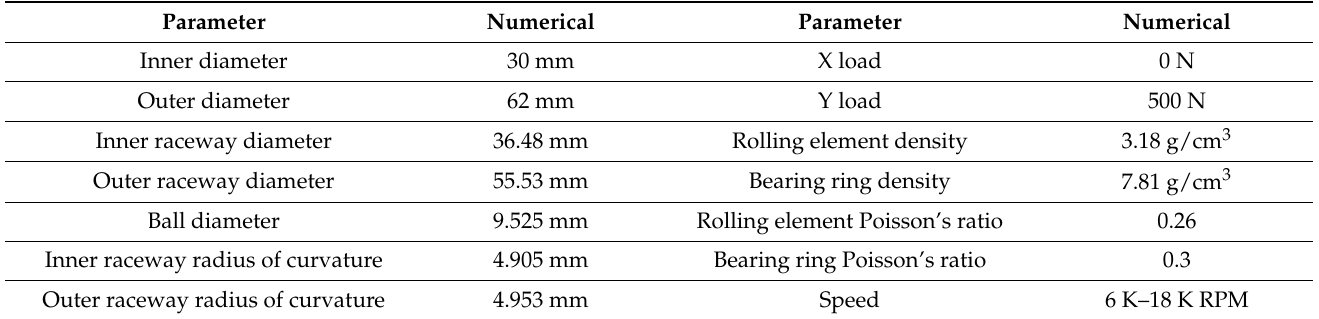
Table 1. Parameters of the cageless bearing and initial values in the numerical simulation.